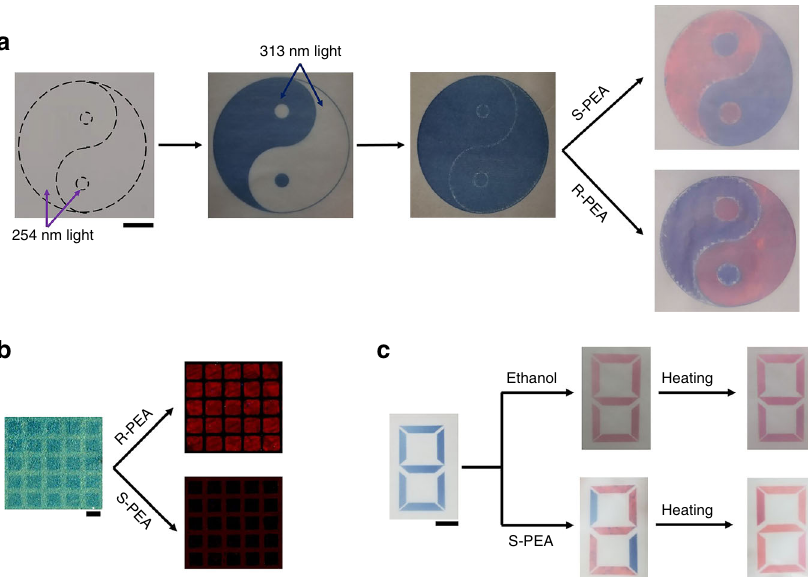
Fig. 4 Photopatterning of chiral PDA into various 2D patterns. a Tai-Chi patterns where the red and blue regions fi lled with left-handed and right-handed PDA when stained with a small chiral alcohol. The fi lling colors are switched for the two enantiomers of the alcohol. Scale bars, 1 cm. b A microarray of chiral PDA patches in 5 µ m × 5 µ m squares and 2 µ m spacing. Scale bars, 5 µ m. c A piece of hidden information coded with chirality that can be deciphered with chiral molecules only. Scale bars, 1